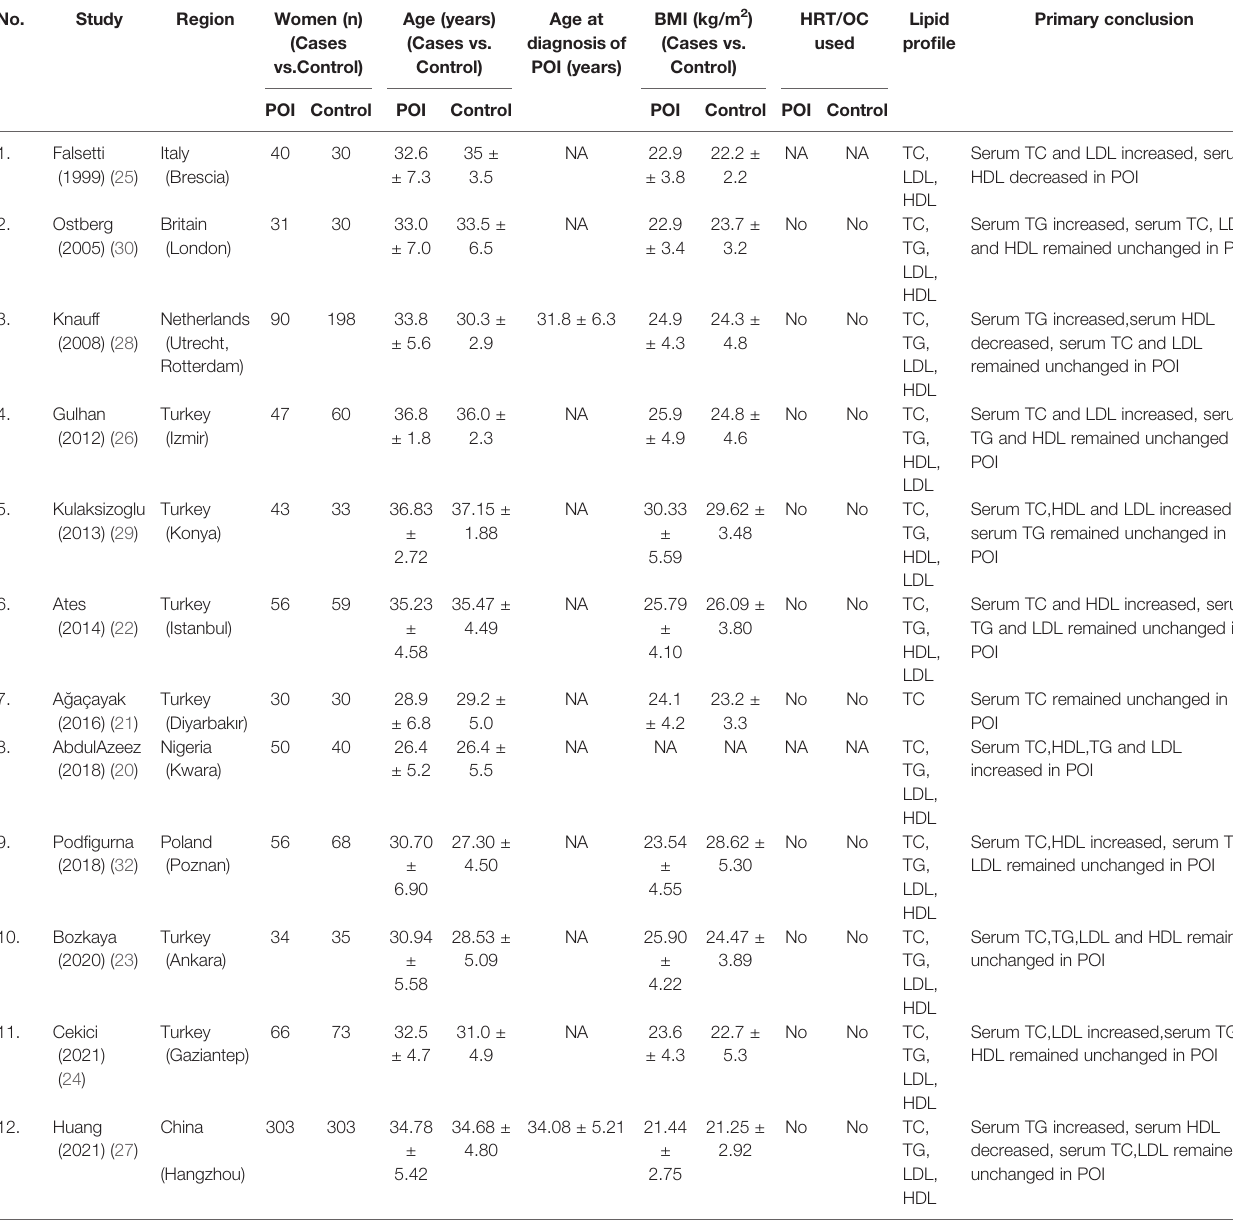
TABLE 1 | Summary characteristics of studies and participants. No. Study Region Women (n)